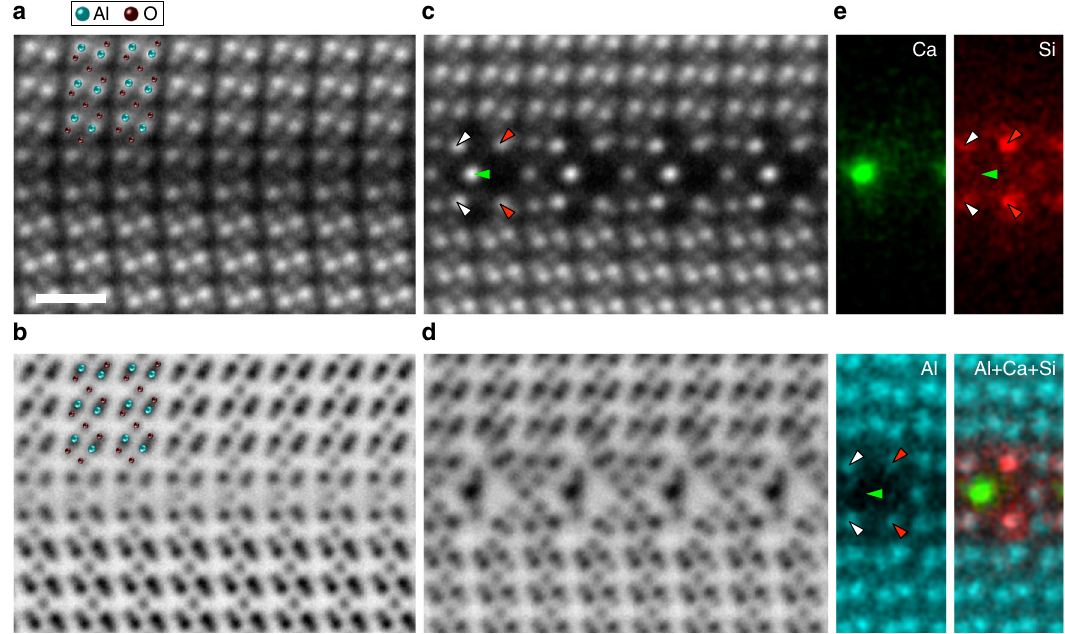
-- -- Fig. 1 | Atomic-resolution STEM images of Σ 13(10 14)/[11 20] GB in α -Al 2 O 3 ofCa- K (green),Si- K (red),Al- K (cyan)edges,andtheiroverlay,respectively.Thegreen, -- viewed along the [11 20] axis. ADF- and ABF-STEM images of a , b pristine GB and red,andwhitearrowheadscorrespondtothepositionsofCa,Si,andweaklyobserved c , d Ca/Si co-doped GB, respectively. e Atomic-resolution STEM-EDS elemental maps Si, respectively. The scale bar in a is 5Å, which applies to all the